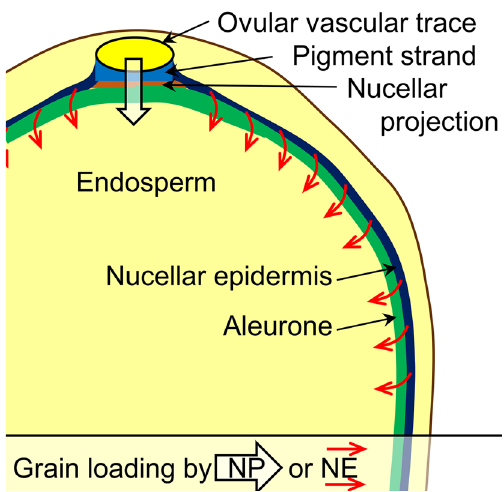
Figure 6. Pathways of nutrient loading into a developing rice grain. The grain is loaded from the ovular vascular trace, with nutrients following two potential pathways into the grain. Initially, grain loading may be dominated by crossing the pigment strand and nucellar projection to enter the filial tissues of the aleurone and endosperm. Later in grain filling the circumferential pathway dominates, with nutrients traveling through the nucellar epidermis around the grain to enter the filial tissues of the aleurone and endosperm. Both DMA and arsenite primarily follow circumferential loading. Image created using Adobe